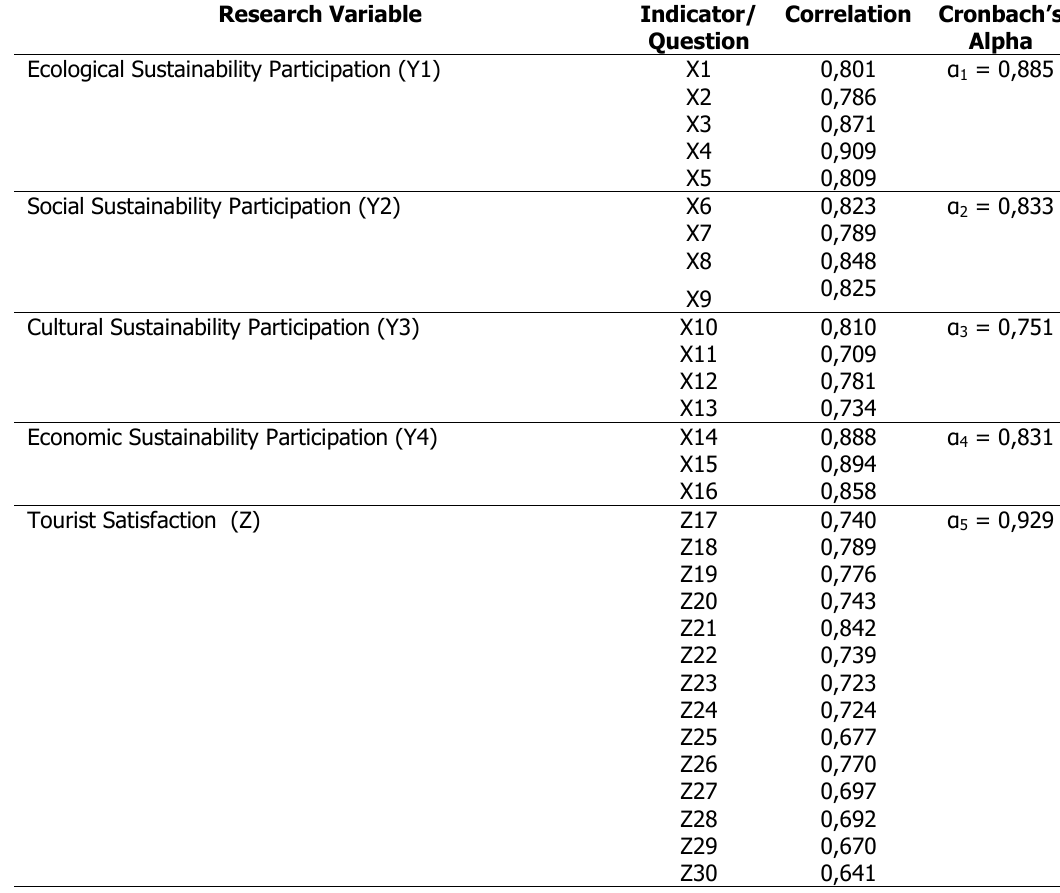
Table 7. The validity and reliability test results of the construct between the research variables and the